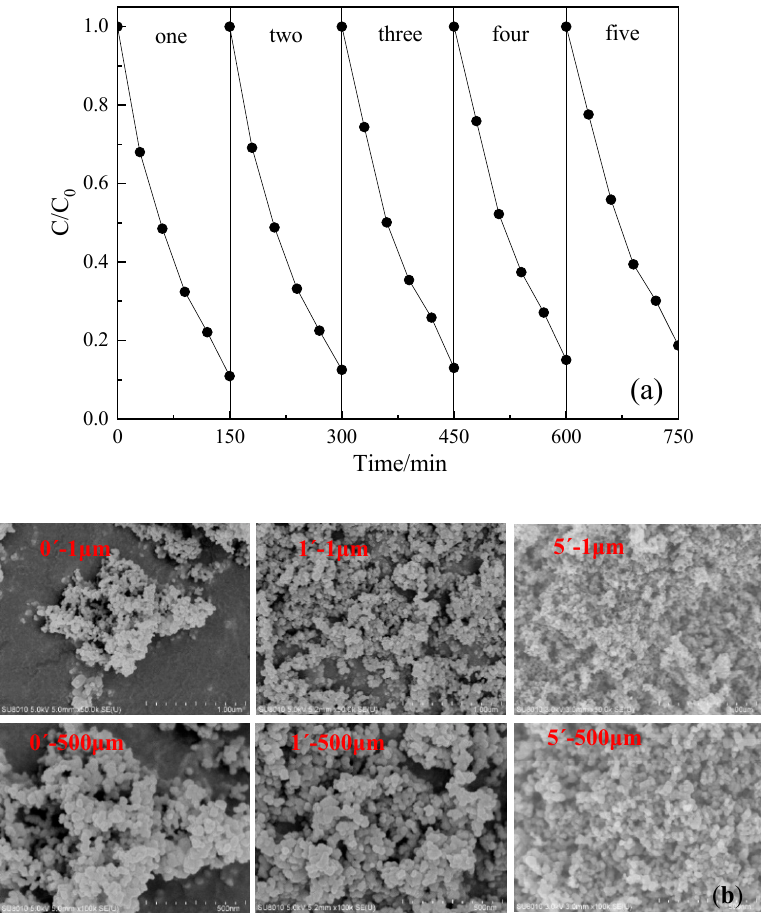
Figure 10. ( a ) is repeatability of photocatalytic, ( b ) is the SEM images of TiO 2 during the photocatalytic degradation of DCF in actual sewage.